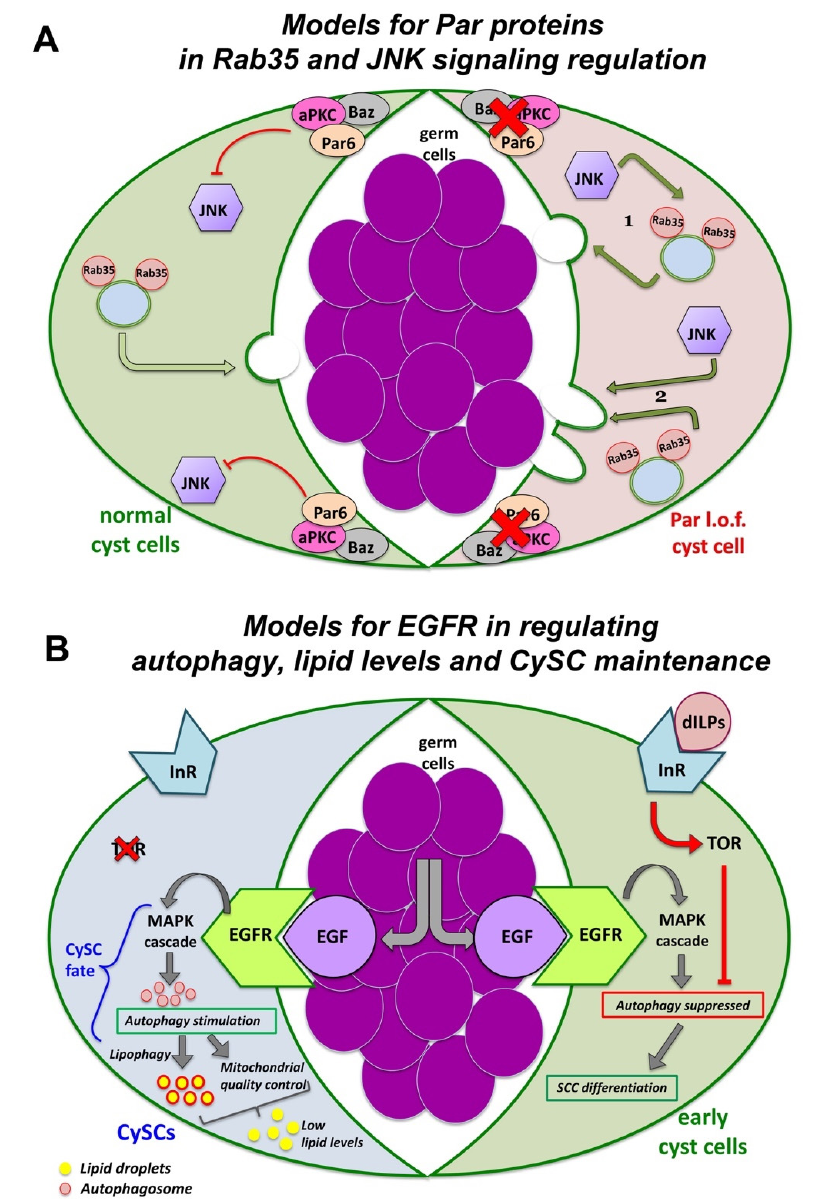
Figure 4. Pathways of signaling, trafficking and autophagy in squamous cyst cells (SCCs) of the Drosophila testis. ( A ) PAR components suppress JNK signaling in SCCs. In normal (wild type) SCCs, the PAR complex reduces JNK pathway activation (left SCC shown in green). In PAR loss of function (l.o.f.) SCCs (right SCC shown in red), de-repression of JNK signaling leads to spermatocyte death. JNK may act (1) by cooperating with Rab35 to deliver the death signal to the germline or (2) independently (but in parallel to Rab35) to induce spermatocyte phagocytosis by the SCCs. (diagram adapted with modifications from Ref. [166]). ( B ) EGFR stimulates autophagy to control lipid levels and CySC maintenance. In CySCs, binding of the EGF ligand Spitz to the EGFR activates the MAPK signaling cascade and stimulates autophagy. Autophagy prevents the accumulation of lipids, which would otherwise compromise GSC homeostasis and survival. Lipophagy and mitochondrial quality control (through fatty acid oxidation) further reduce lipid accumulation. In early-stage SCCs, TOR via the ILR-PI3K-TOR pathway, suppresses autophagy temporarily and allows SCC differentiation to proceed (diagram adapted with modifications from Refs. [167,168]). To simplify the diagrams, two different cyst cells are depicted in ( A , B ) as part of the same cyst cell-germline